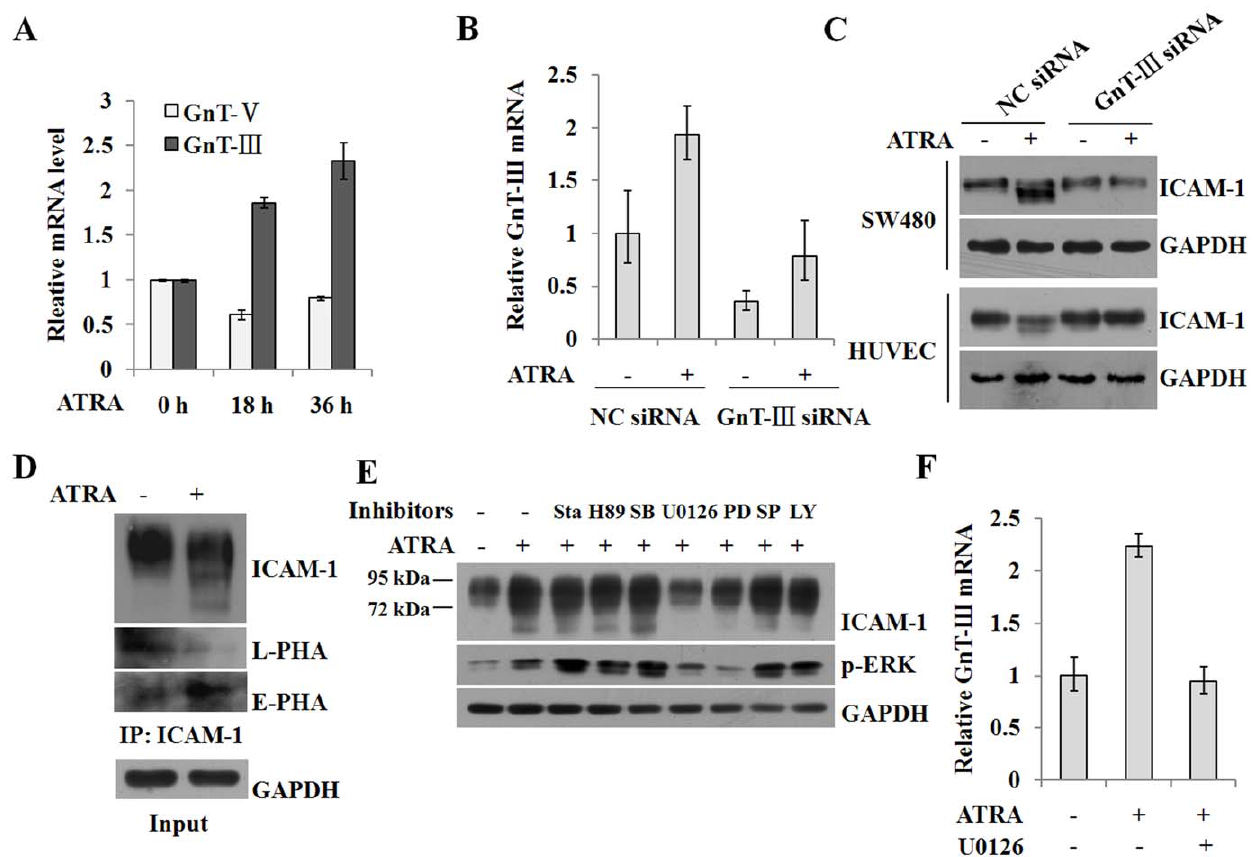
Figure 3. ATRA-induced GnT-III expression is involved in the modulation of ICAM-1 N -glycan composition. A, SW480 cells were treated with 25 m M ATRA for 0, 18 and 36 h. The expression of GnT-III and GnT-V at the mRNA levels was detected by real-time RT-PCR (n=3). B and C, SW480 cells that were transiently transfected with 50 nM of the siRNA specifically targeting GnT-III were treated with 25 m M ATRA. The efficiency of transfection was analyzed by real-time RT-PCR (n=3, B) and the expression of ICAM-1 by Western blot (C). D, SW480 cells were treated with 25 m M ATRA. Then immunoprecipitation by the antibody against ICAM-1 (1.5 m g per 500 m g of total protein) was performed. The immunoprecipitated products were subjected to 10% SDS-PAGE, transferred to a nitrocellulose membrane and consecutively incubated with biotinylated L-PHA or E-PHA lectin, streptavidin-labled rabbit IgG and HRP-labeled goat anti-rabbit IgG. Bound HRP on the membranes was detected by ECL. E, SW480 cells were pretreated with 0.7 nM stauroporine, 10 m M H-89, 10 m M SB203580, 10 m M U0126, 50 m M PD98059, 20 m M SP600125 or 50 m M LY294002 for 2 h and then exposed to 25 m M ATRA for 36 h. The expression of ICAM-1 and phosphorylation of ERK were analyzed by Western blot. F, SW480 cells were pretreated with 10 m M U0126 and then with 25 m M ATRA. The expression of GnT-III at the mRNA level was analyzed by real-time RT-PCR